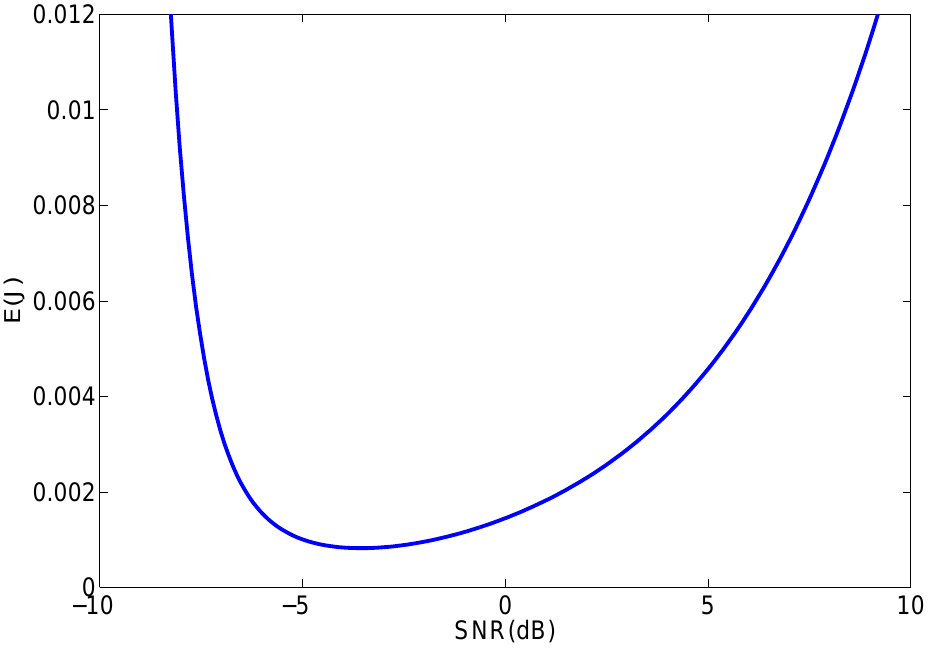
Figure 1. Energy consumption (in joules) as a function of the SNR at the